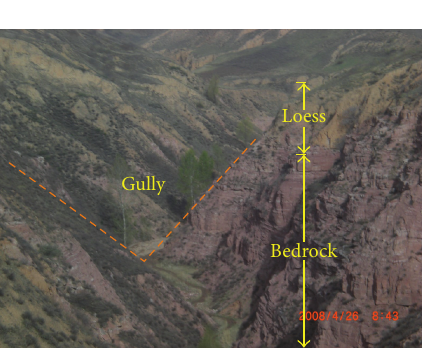
Figure 2: A photo of Houhayewusu Gully at underground mining